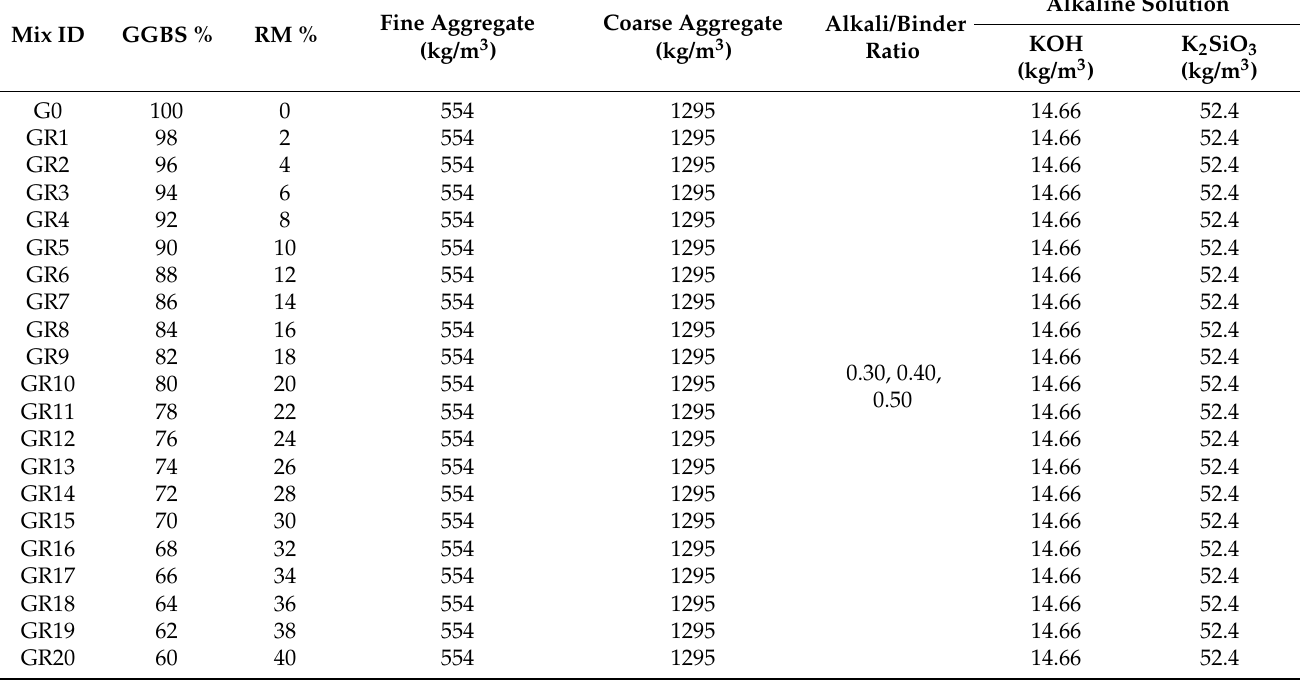
Table 3. Mix proportion of